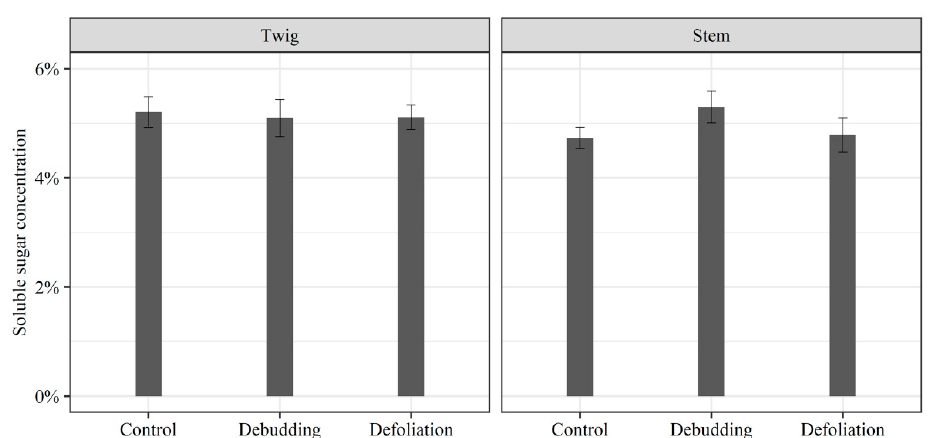
Figure 5. Responses of concentrations of NSC, soluble sugar, and starch in stems and twigs of seedlings to defoliation and debudding treatments in one year. The results are shown as the mean ± standard error. The mean values of each treatment are the average of 5–10 replications (5 replications for defoliation, 8 replications for debudding, and 10 replications for control). Significant differences are denoted with different lowercase letters.